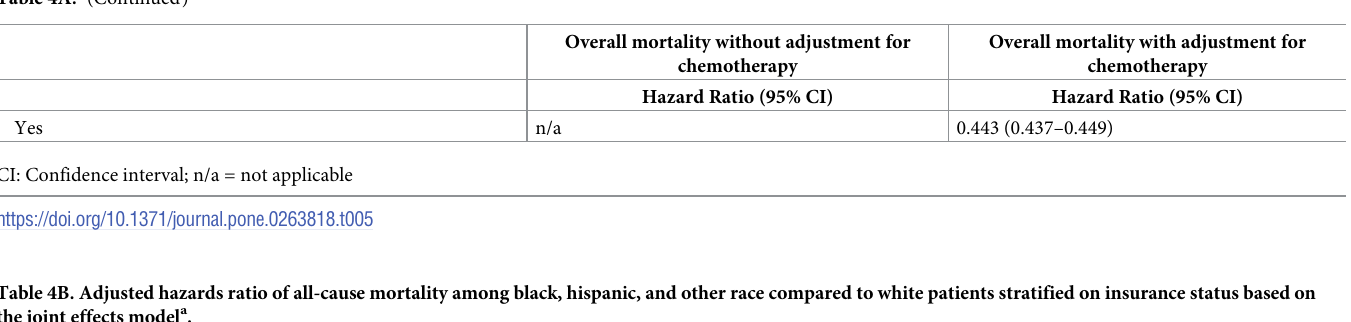
Table 4B. Adjusted hazards ratio of all-cause mortality among black, hispanic, and other race compared to white patients stratified on insurance status based on the joint effects model a . Insurance Status Race (ref = Non-Hispanic Overall mortality without adjustment for White)